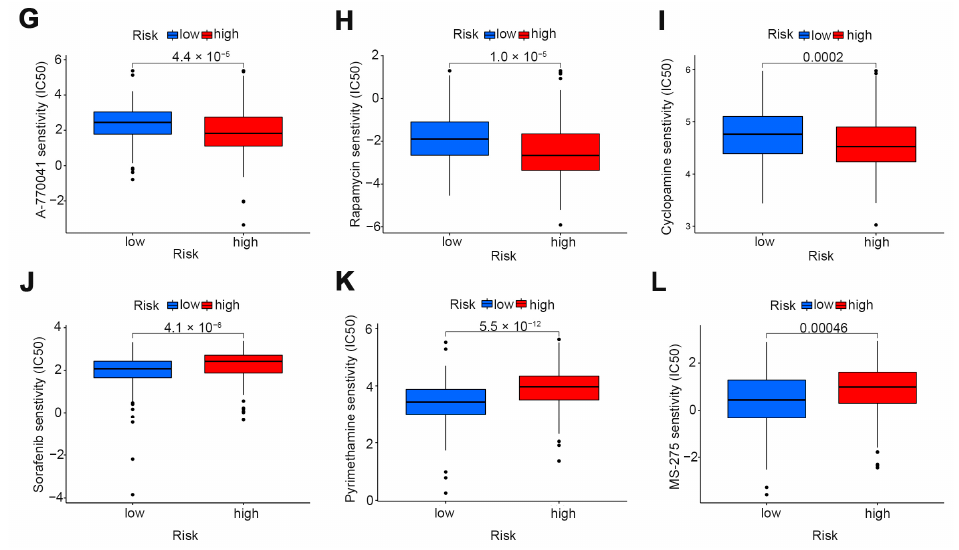
Figure 6. A-770041 ( A , G ), rapamycin ( B , H ), cyclopamine ( C , I ), sorafenib ( D , J ), pyrimethamine ( E , K ), and MS-275 ( F , L ) drug correlation and sensitivity analysis.